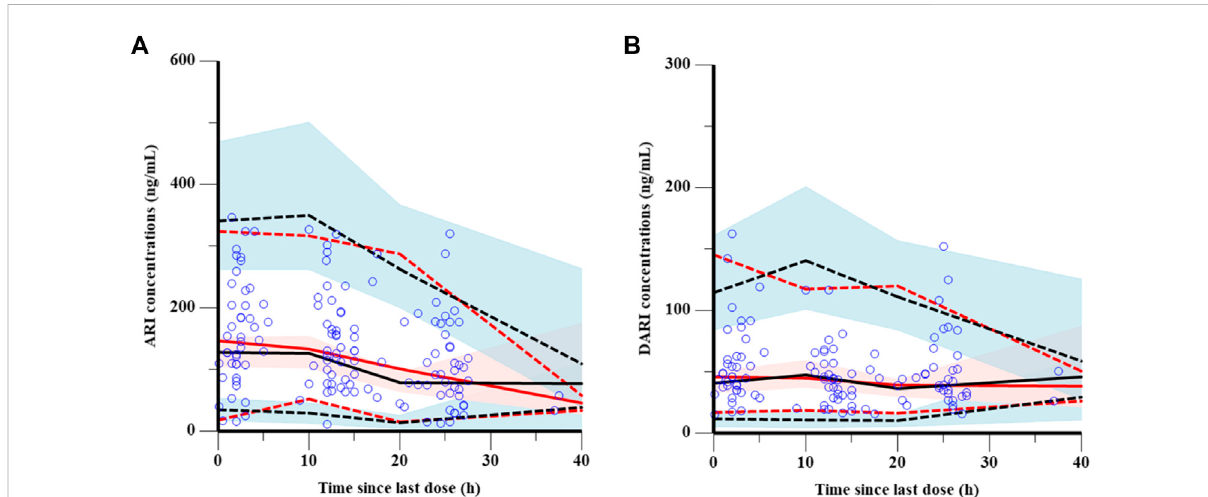
FIGURE 2 Visualpredictionchecksofthe fi nalmodelforARI (A) andDARI (B) .Thebluepointsrepresenttheobservedvalue.Thedashedandsolidredlines are the 5th percentile, 95th percentile and the median of the observed concentrations, respectively. The dashed and solid black lines are the 5th percentile, 95th percentile and the median of the simulated concentrations, respectively. The shaded areas represent the 90% predicted intervals of the 5th, 50th and 95th percentiles of the simulated data, respectively.